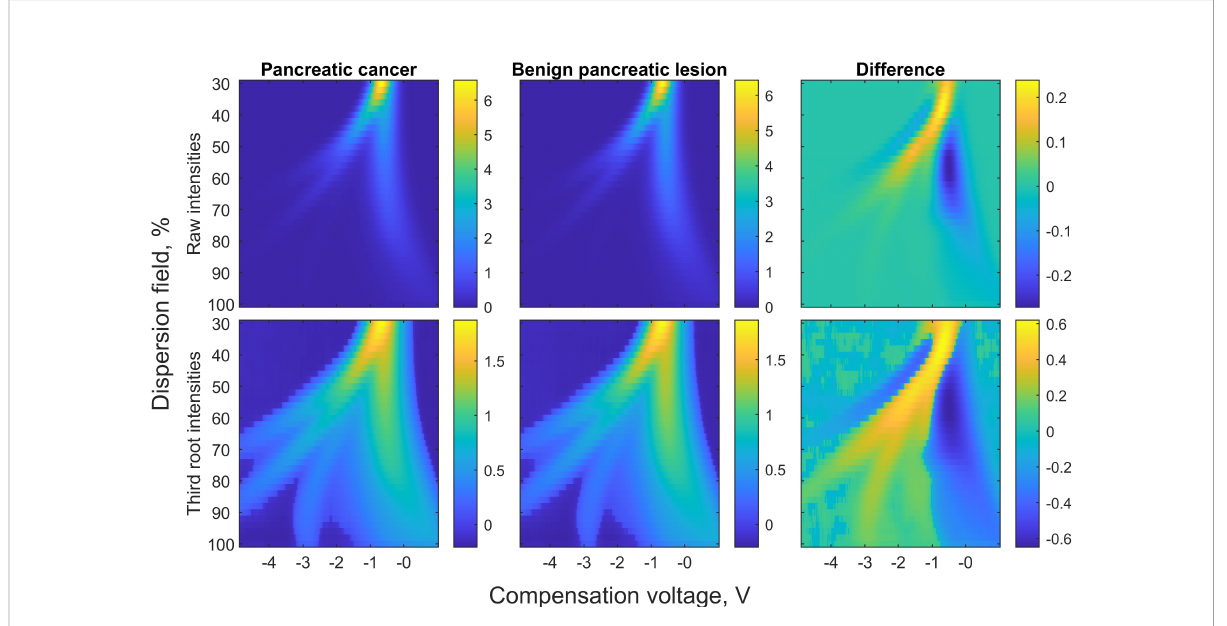
FIGURE 1 FAIMS spectra of bile in pancreatic cancer and benign pancreatic lesion groups and their differences. In the fi rst row, water molecules bend far left in the electric fi eld, while indistinguishable molecules composing the background spike bend to the far right. Discriminative molecules are found between these two. In the second row, the differences are accentuated by calculating third